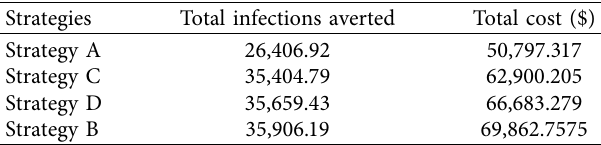
Table 6: Total amount of infection averted and total cost for all strategies. Strategies Total infections averted Strategy A Strategy C Strategy D